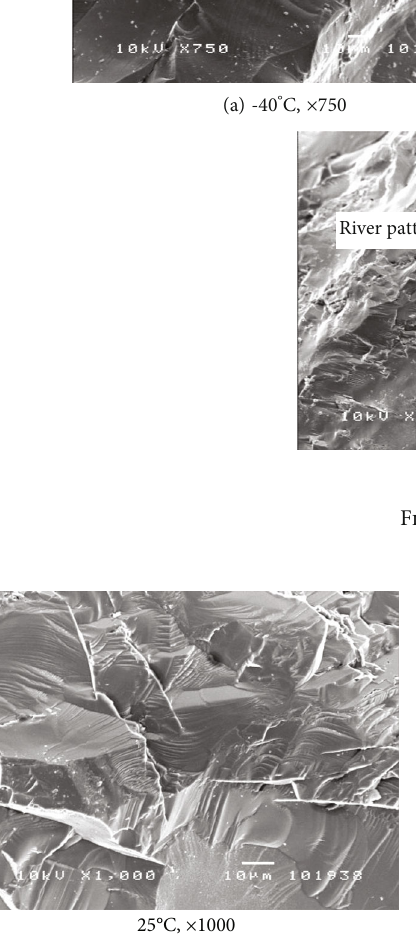
Figure 7: Curved facet and river pattern.